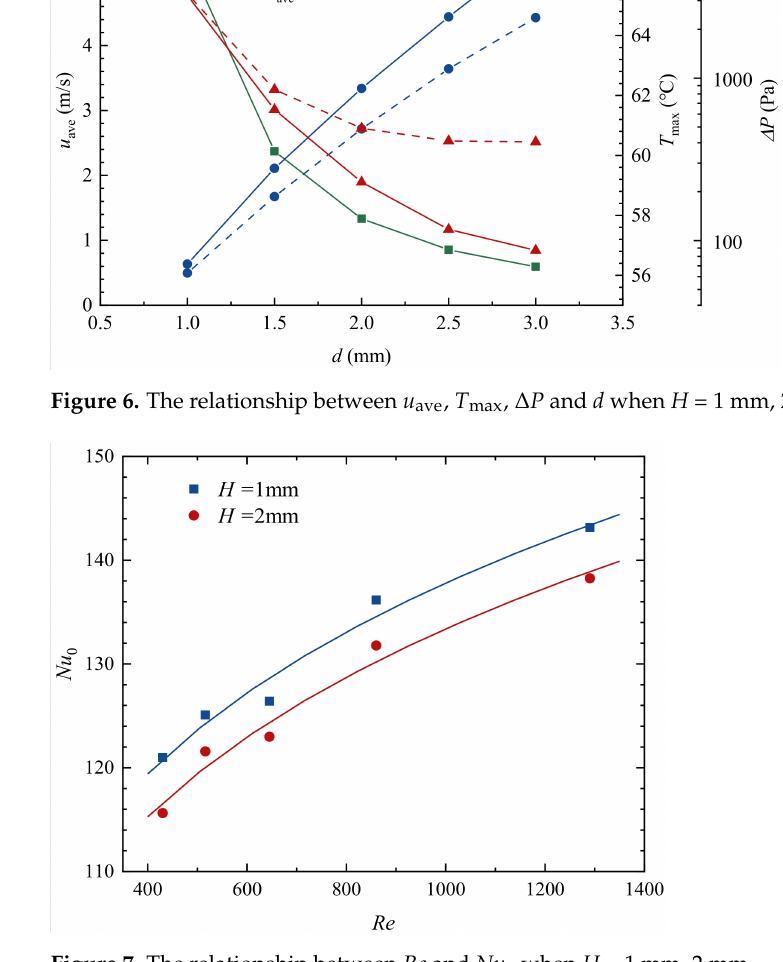
Figure 7. The relationship between Re and Nu 0 when H = 1 mm, 2